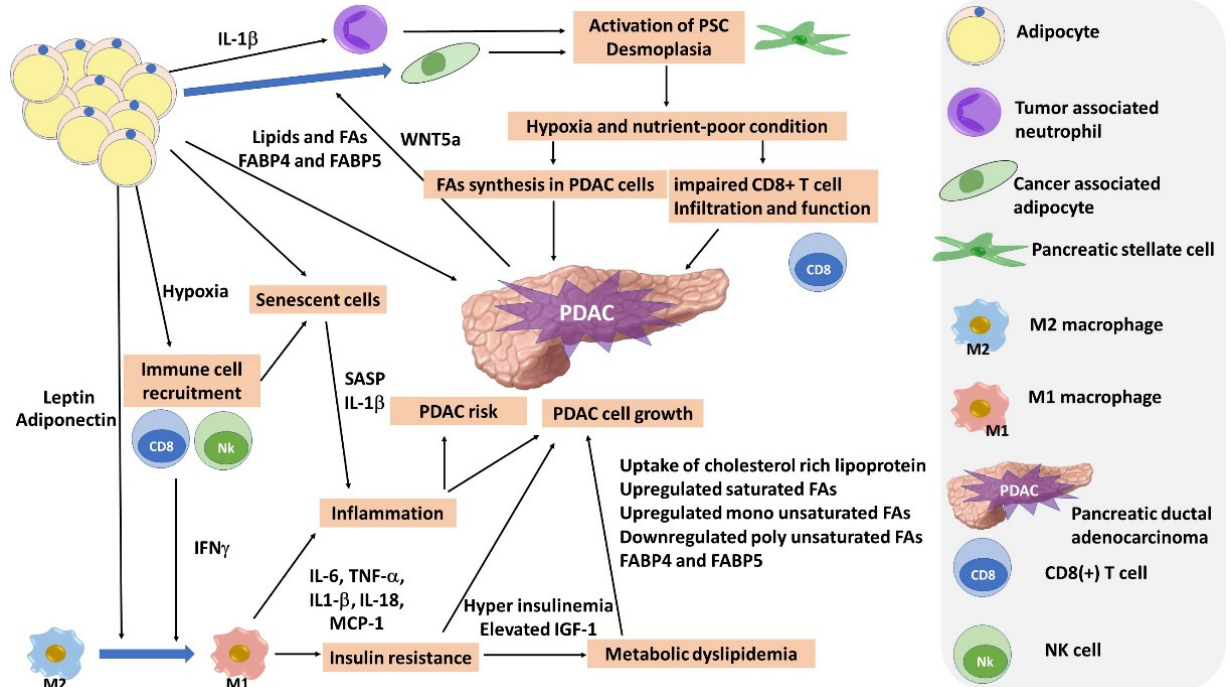
Figure 1. The pancreatic cancer environment in obese individuals. Adipose tissue and its inflamma- tion play a central role in carcinogenesis and the tumor microenvironment. Adipokines, cytokines and chemokine, and other inflammatory mediators secreted by adipose tissue affect the pancreas. Adipose tissue inflammation also causes insulin resistance. Elevated insulin levels are known to cause PDAC cell growth and metabolic dyslipidemia. Dysregulation of lipid metabolism also plays an important role in cancer cells. In particular, (i) enhanced extracellular uptake of cholesterol, (ii) elevated fatty acid synthesis, (iii) imbalance between unsaturated and saturated fatty acids, and (iv) abnormal FABP expressions are important metabolic changes in PDAC cells.